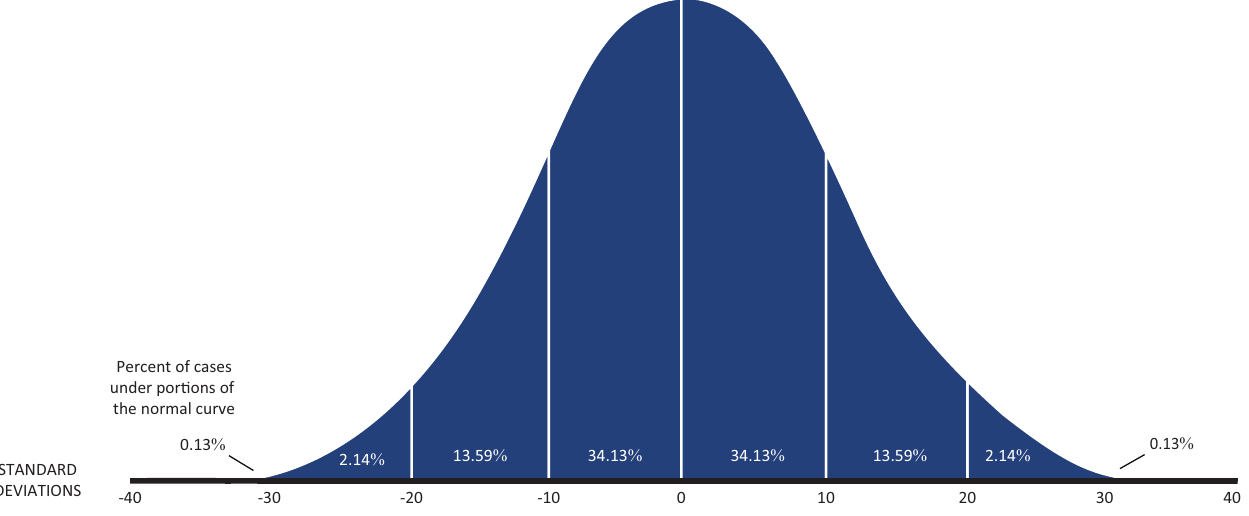
FIGURE 2: Bell curve psychological testing: normal distribution, the myth of the bell